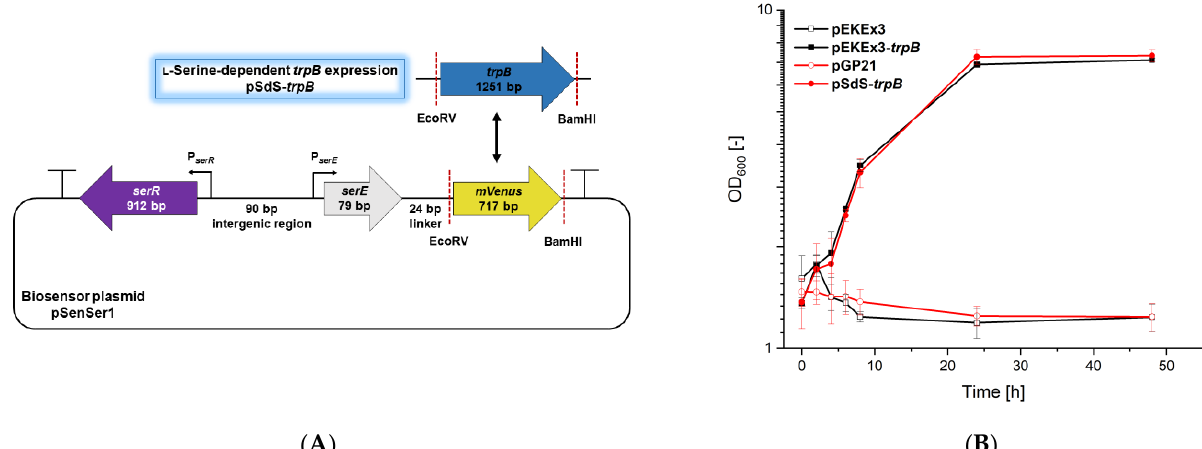
Figure 5. ( A ) Construction of the L -serine-switch plasmid pSdS- trpB for L -serine-dependent trpB expression. Biosensor plasmid pSenSer1 was double-digested with EcoRV and BamHI to replace the mVenus with trpB gene. ( B ) Growth of SER2 (pEKEx3- trpB ) (black filled squares) and SER2 (pSdS- trpB ) (red filled circles) and their corresponding control strains with empty vector in hollow symbols. Cells were grown under L -serine-producing conditions (i.e., folate starvation) in CGXII minimal medium with 1 mM indole supplementation. Values are means and errors of three cultures.